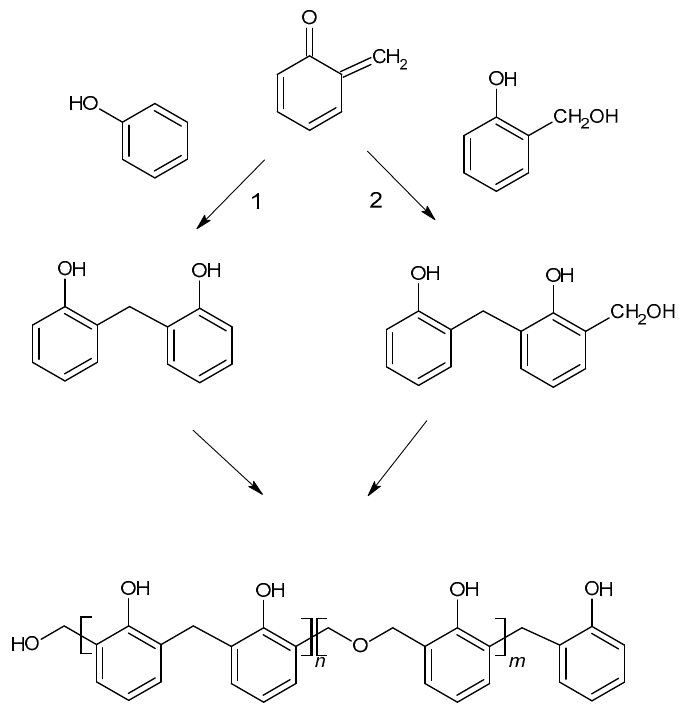
Figure 4. The formation of the quinone methide.